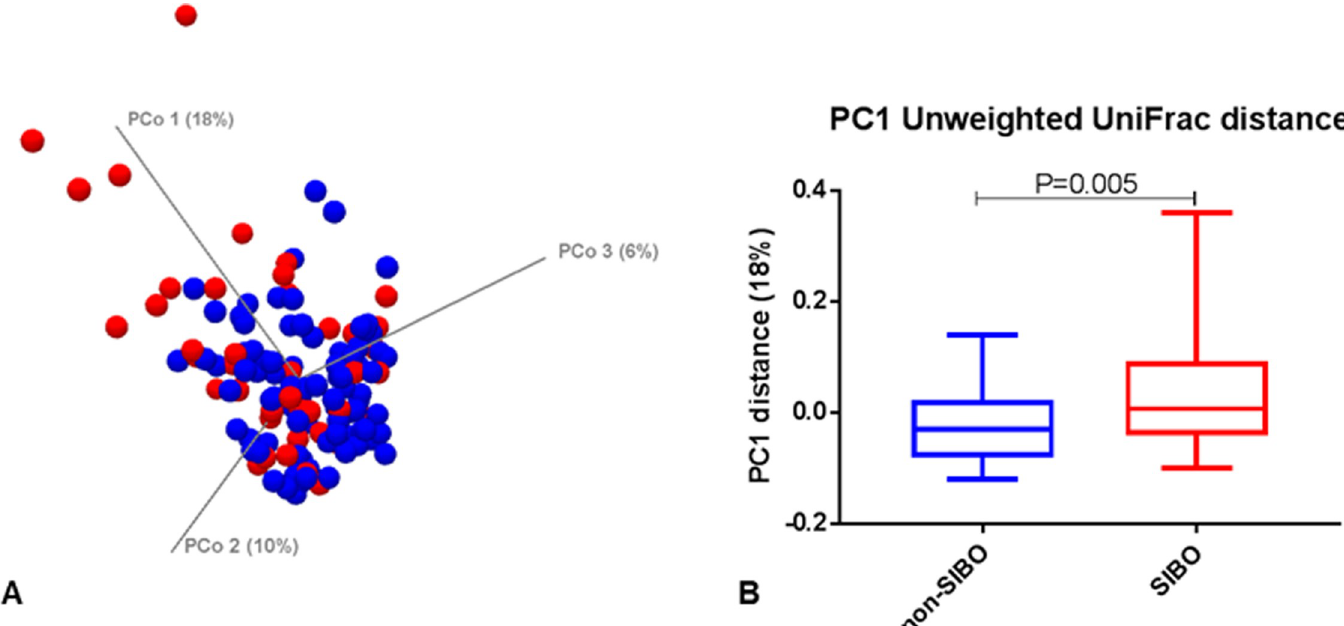
Fig 2. A- Principal Coordinates Analysis (PCoA) of both binary and abundance Unweighted UniFrac distances between SIBO (red) and non-SIBO (blue) subjects. B–PC1 distance plot.